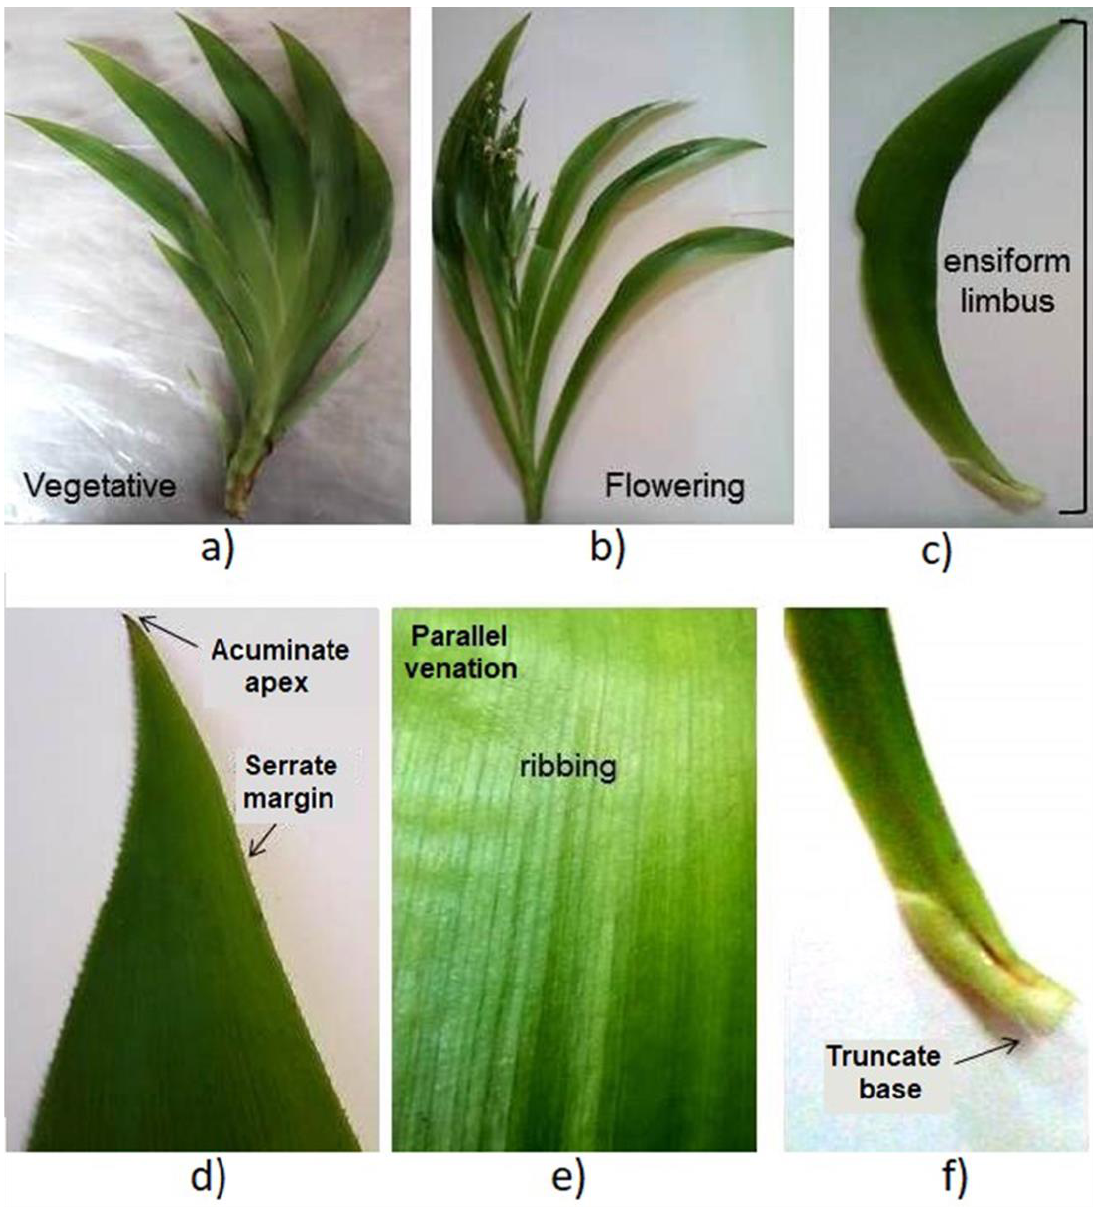
Figure 1. Macroscopic characteristics of the X. caeruleum leaves. ( a ): vegetative stage, ( b ): flowering stage, ( c ): blade, ( d – f ): magnified portions of the leaves, apex and margin ( d ), venation pattern ( e ) and base ( f ).